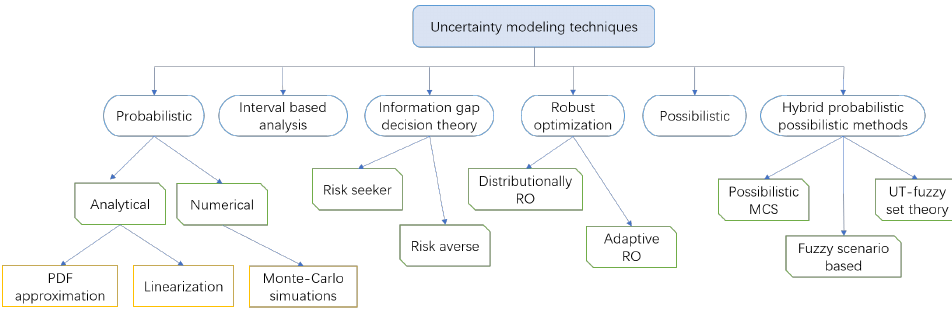
Figure 7. Uncertainty modeling